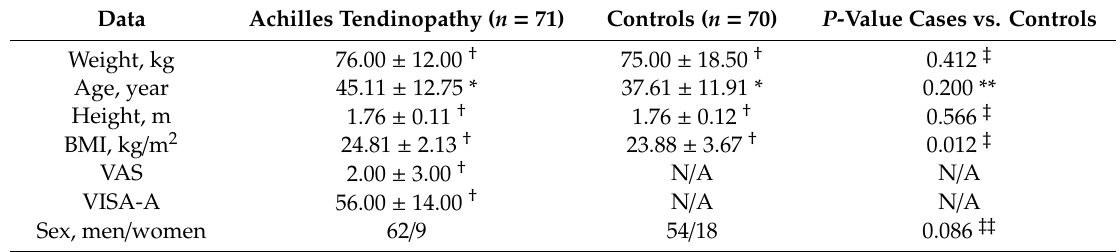
Table 1. Sociodemographic features, pain scores and VISA-A scale of the sample. Data